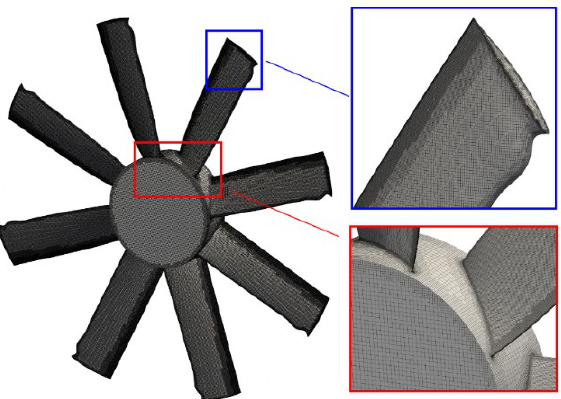
Figure 6. Mesh of the fan and details of the grid at blade tip and hub, whale fan design.